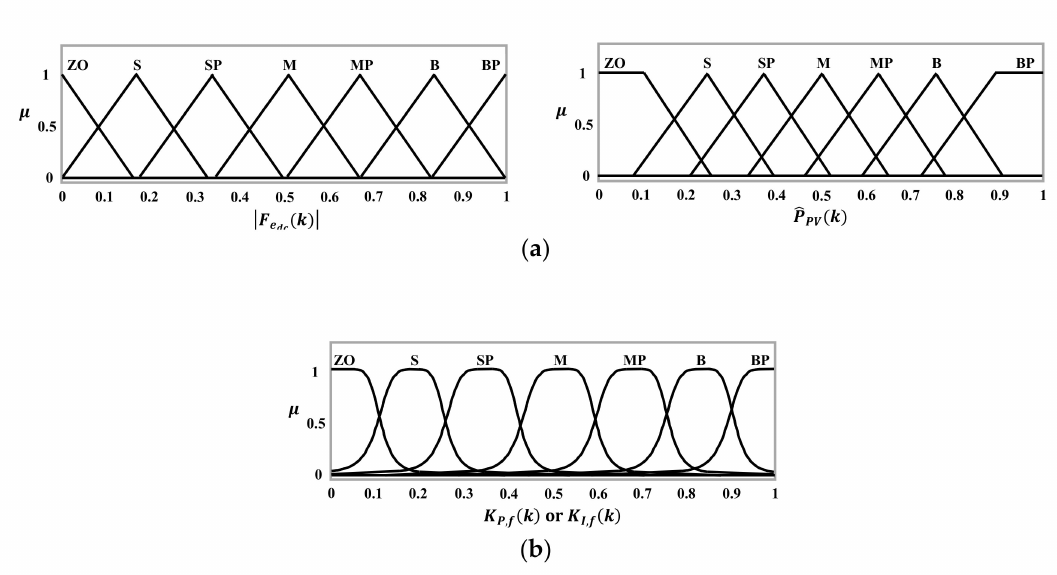
Figure 8. Membership functions in Rule i : ( a ) inputs, and ( b ) outputs.